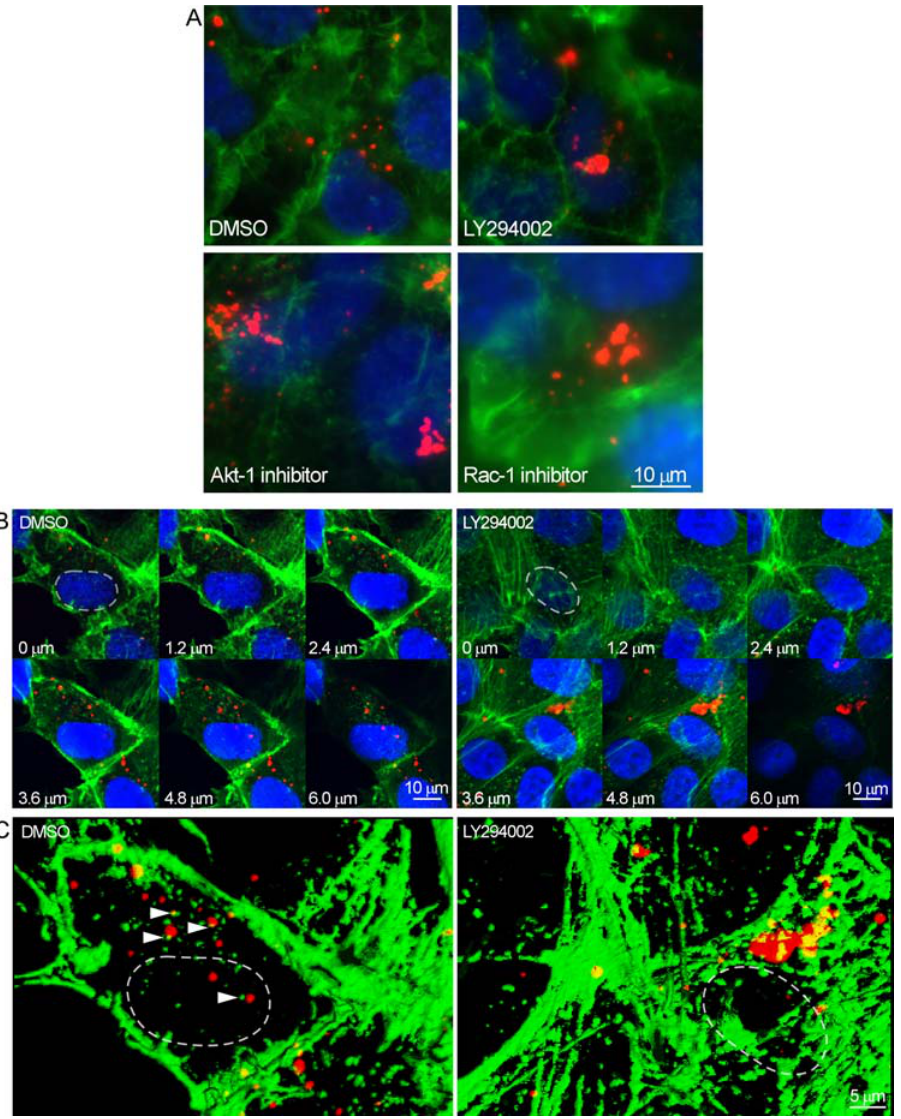
Figure 6. Inhibitors of PI3K, Akt, and Rac1 cause intracellular clustering of ZEBOV particles. (A) HEK293-mCAT-1 cells were grown on chambered coverglass and treated with DMSO (control) or the indicated drugs for 1 h, followed by incubation with fluorescently labeled ZEBOV (red) for 3 h. Cells were fixed, permeabilized, and incubated with Alexafluor488-labeled phalloidin to visualize F-actin and DAPI to stain nuclei (blue). Subsequently, slides were washed and photographed by fluorescence microscopy using a 100 6 oil immersion objective. Scale bars are shown at lower right and apply to all images in the panel. (B) The observations made using HEK293-mCAT-1 cells were confirmed in Vero-E6 cells by confocal microscopy. (Top panel) Serial optical sections of cells treated for 1 h with DMSO (left) or the PI3K inhibitor LY294002 (right) and then incubated with fluorescently labeled ZEBOV (red) for 2 h. Cells were fixed and stained with phalloidin to label F-actin (green) and DAPI to label cell nuclei (blue). The level of the section is indicated, with 0 on the basolateral cell surface and 6 m m close to the apical surface of the cell. (C) Volume projection of all optical z-sections (computed using ImageJ software) of representative cells incubated in the presence of DMSO or LY294002. In DMSO-treated cells, examples of actin bundles adjacent to virus particles are indicated by arrowheads. Only the red and green fluorescence channels are shown, and the nuclei of chosen cells are indicated with dashed lines.